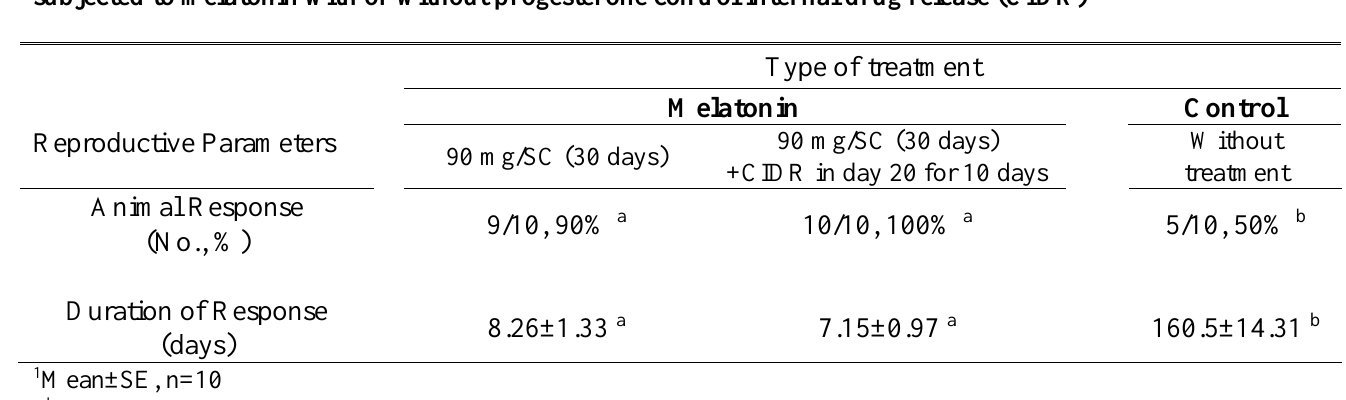
Table 1. Animal response (Number, %) and duration of response (days) of anestrous lactating Iraqi buffaloes subjected to melatonin with or without progesterone control internal drug release (CIDR) 1